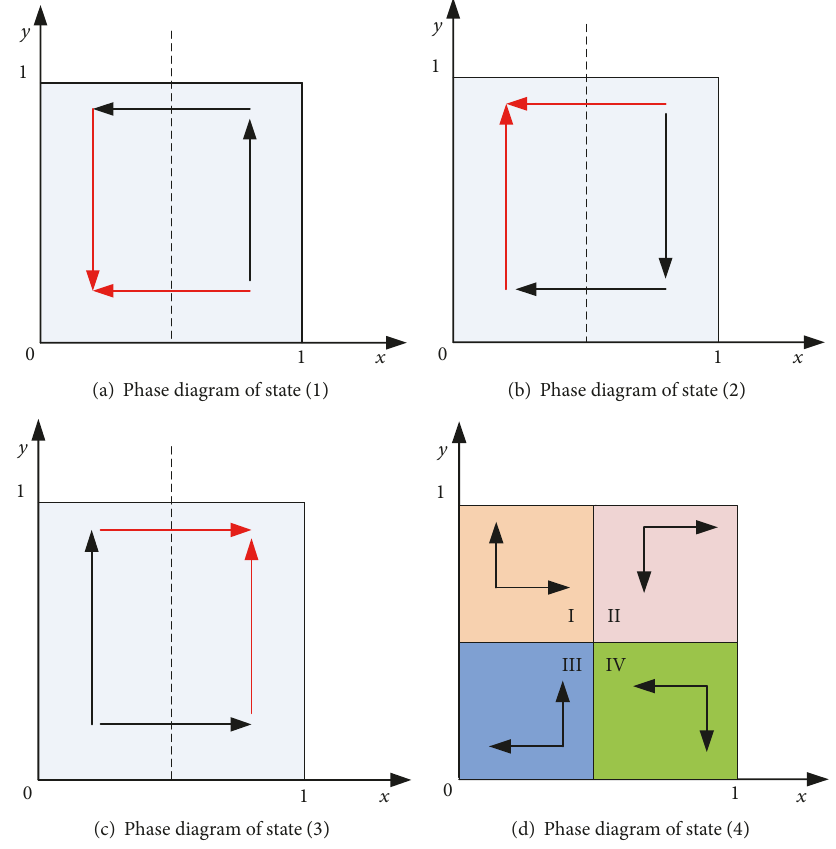
Figure 1: Phase diagram in different